Question: Summarize what this figure shows in one sentence.
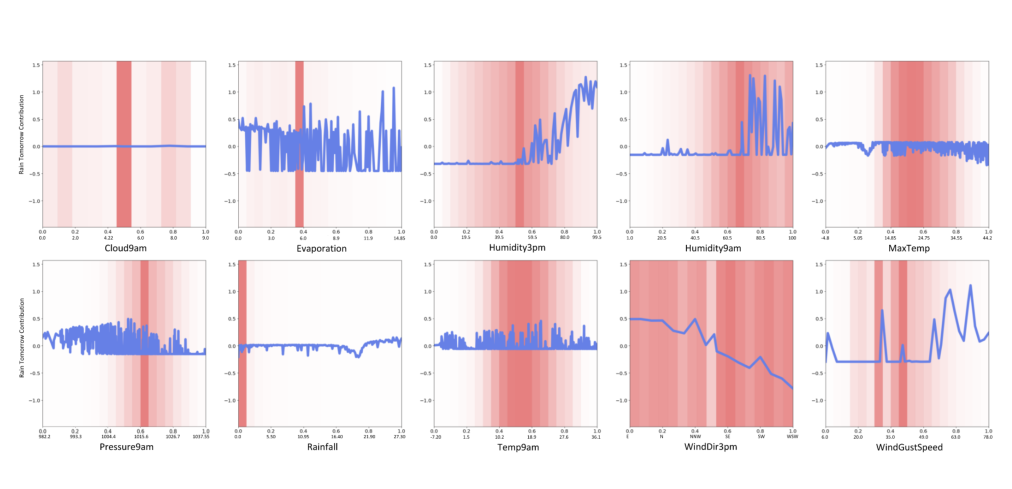
Answer: Weather Graphs learned by FocusLearn in predicting whether it will rain tomorrow (classification) on the Weather dataset. These plots show top 10 features selected by the AFS component in the FocusLearn, where selected features with normalised and original values are on the x-axis, and contribution towards the prediction are on the y-axis.